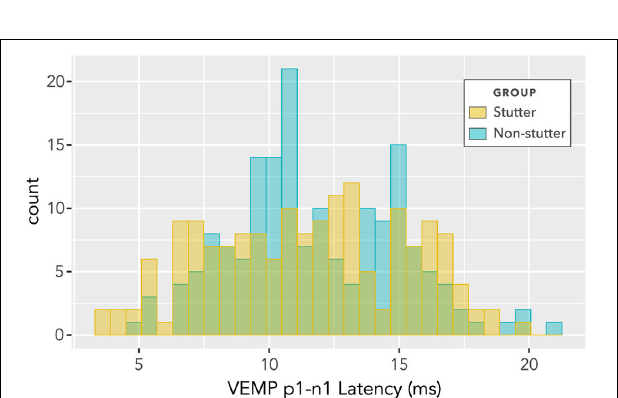
FIGURE 11 | Final model for VEMP amplitude. The disturbance represents influences other than those measured in the model, and is the square root of (1 – R 2 ), where the conditional R 2 is calculated according to Nakagawa et al. (2017) using the MuMIn package (version 1.43.17). For the control group, using the calibrations and data transformations in this report, the y -axis intercept is − 24.9 dB RL (95% CI [ − 32.6, − 17.2]). The suggestion is of VEMP thresholds at 20.3 dB HL for the stutter group and 11.8 dB HL for the non-stutter group. However, VEMP thresholds projected in this way (extrapolation to 0 dB RL) assume a linear relationship between stimulus level and VEMP amplitude over a wider range of stimulus levels than was tested in this study. Such projections are dissimilar to VEMP thresholds evaluated by clinical search procedures (e.g., as per British Society of Audiology, 2012). Clinical VEMP thresholds refer to the smallest VEMP p1-n1 amplitudes which can be recorded against electromyographic background in a particular laboratory, and are used for differential diagnosis as part of a test battery (Rosengren et al., 2019).